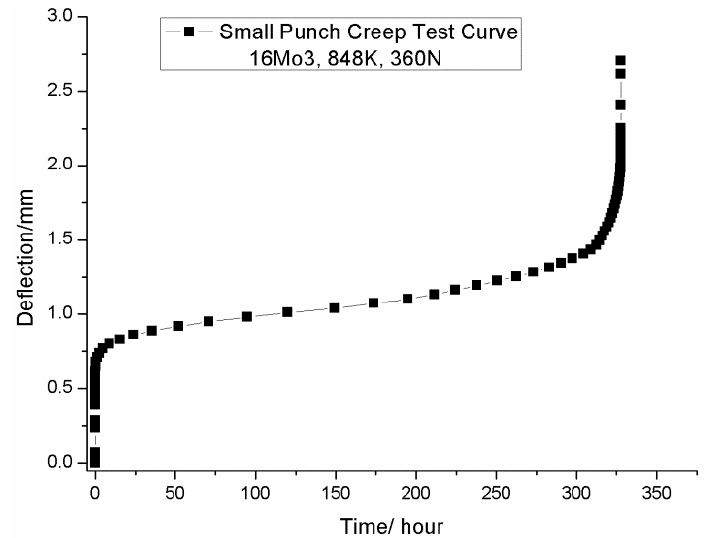
Figure 2. Principle sketch of the small punch test device.